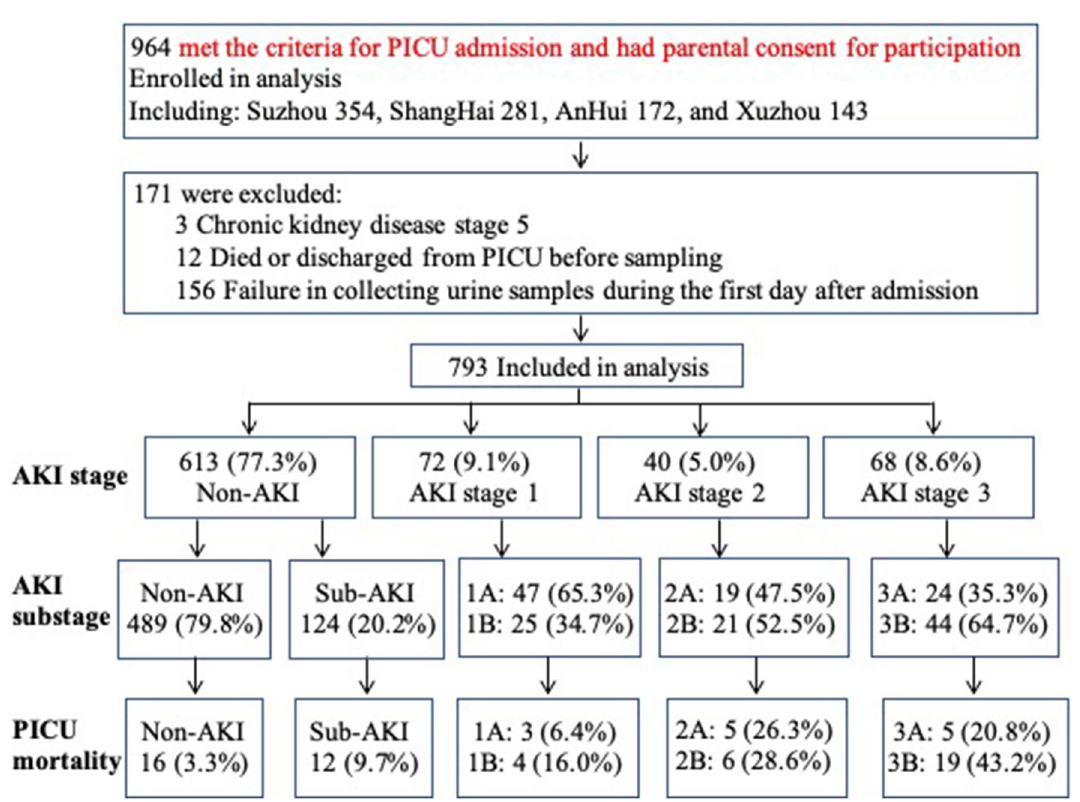
Fig. 1 Flow diagram demonstrating study design. PICU, pediatric intensive care unit; sub-AKI, subclinical AKI